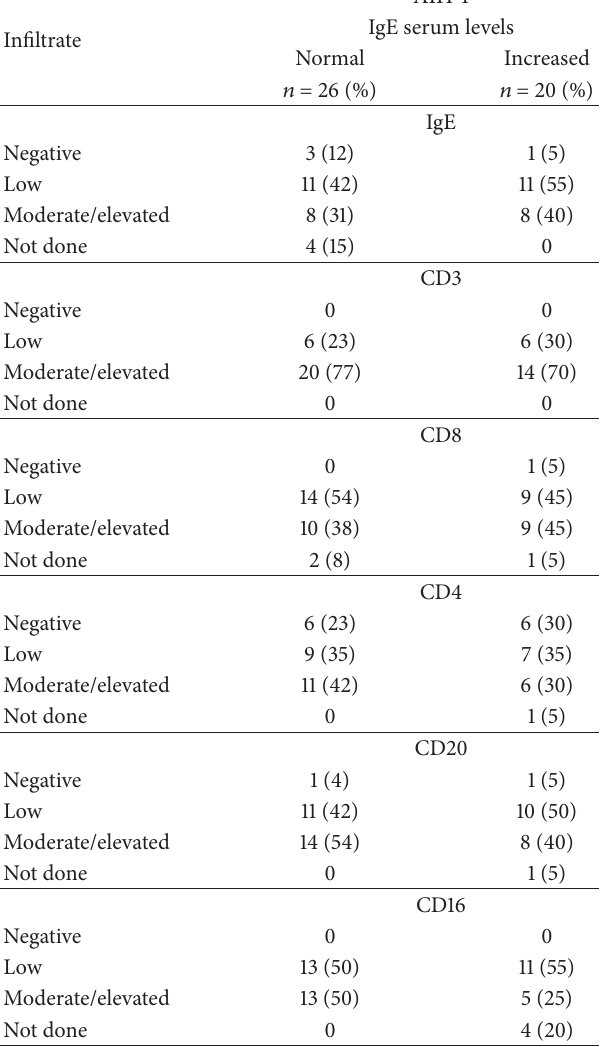
Table 3: Immunohistochemical analysis for tissue IgE, liver- infiltrating T and B lymphocytes, and NK cells in the liver of AIH-1 patients, grouped according to serum IgE levels.